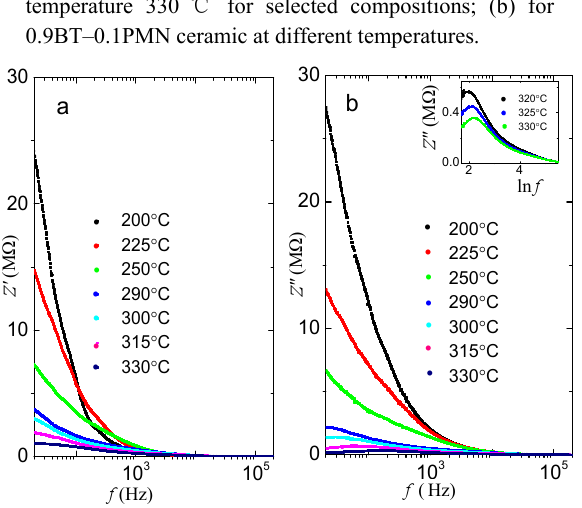
Fig. 9 Frequency plots of (a) Z  and (b) Z  at different temperatures for 0.9BT–0.1PMN. Inset shows the frequency dependence of Z  at high temperature.